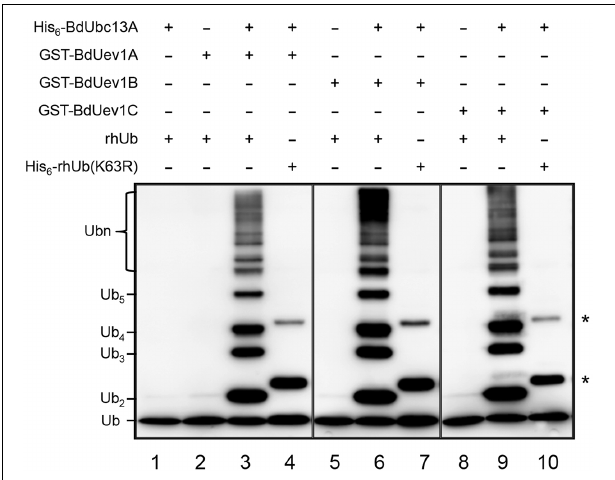
FIGURE 3 | In vitro ubiquitin conjugation assay of BdUev1s using purified proteins. After ubiquitination reactions as described, samples were subjected to SDS-PAGE and Western blotting using an anti-Ub antibody to monitor poly-Ub chain formation. rhUb, recombinant human ubiquitin. Asterisks indicate the non-specific bands in lanes 4, 7, and